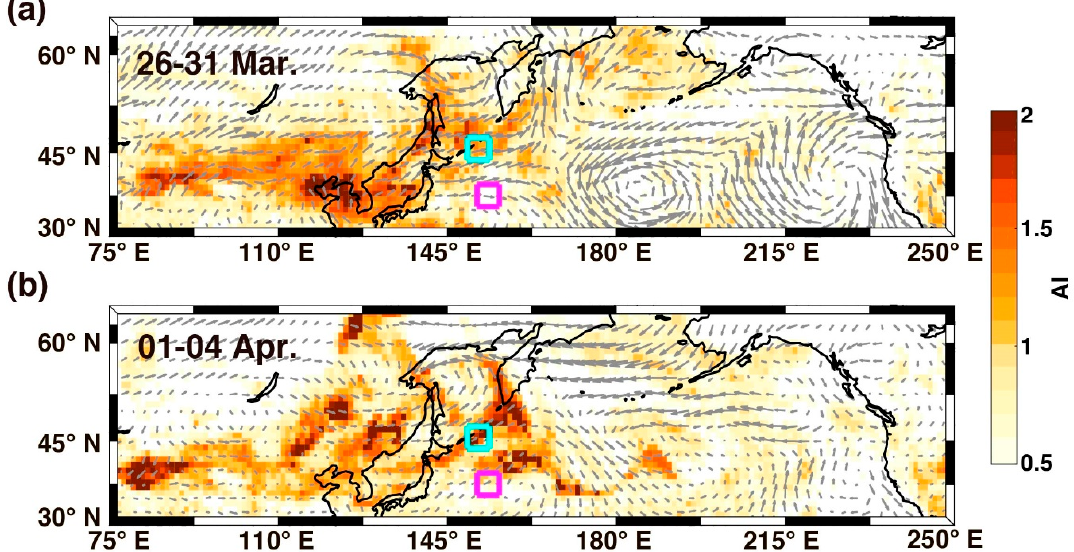
Figure 3. Spatial distributions of AI for ( a ) 26–31 March and ( b ) 1–4 April 2018 in the North Pacific Ocean. The grey arrows represent mean surface wind velocities averaged over 4–6 days spanning dust events. The cyan square (45° N ‒ 46° N and 151° E ‒ 152° E) indicates 1° × 1° region in which AI exceeded the 1.7 threshold value on both events, while the pink square (37° N ‒ 38° N and 153° E ‒ 154° E) indicates 1° × 1° region in which AI values were less than 1. Data from the two areas were used for OPP estimation (refer to Section 4.2).